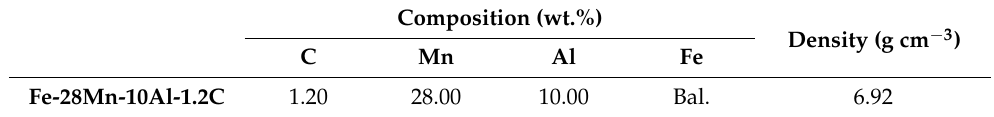
Table 1. Chemical composition (wt.%) and density of Fe-28Mn-10Al-1.2C steel. Composition (wt.%)